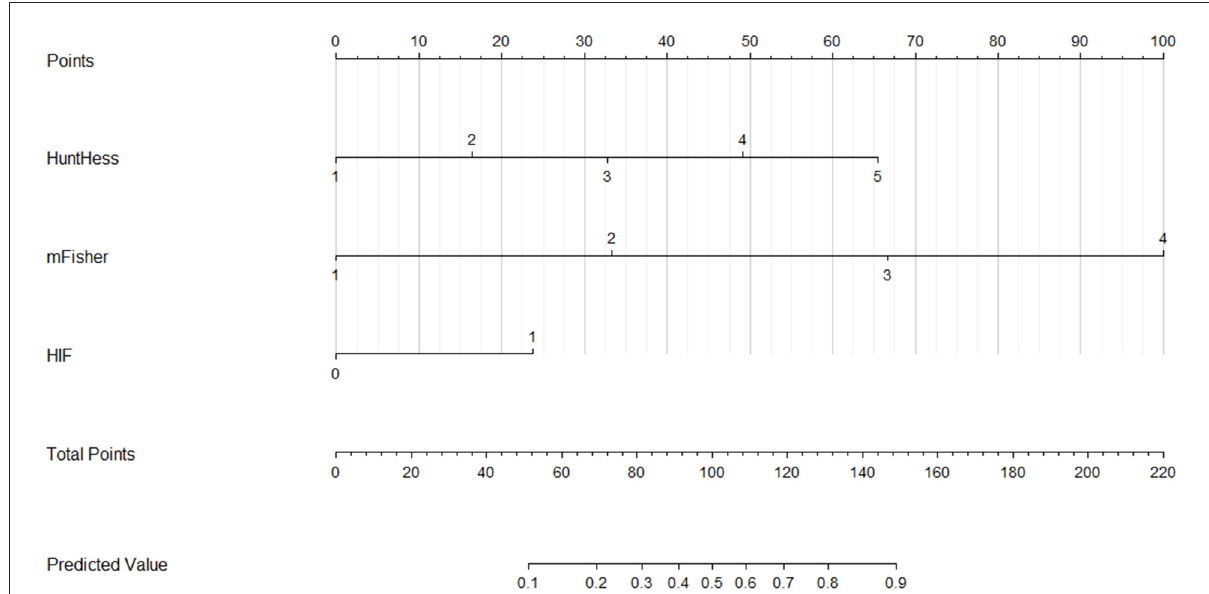
FIGURE8 Nomogram for predicting poor outcome after aneurysmal subarachnoid hemorrhage. Serum hypoxia-inducible factor 1alpha levels combined with Hunt–Hess scores and modified Fisher scores significantly differentiated poor outcomes. For HIF, “1” indicates serum hypoxia-inducible